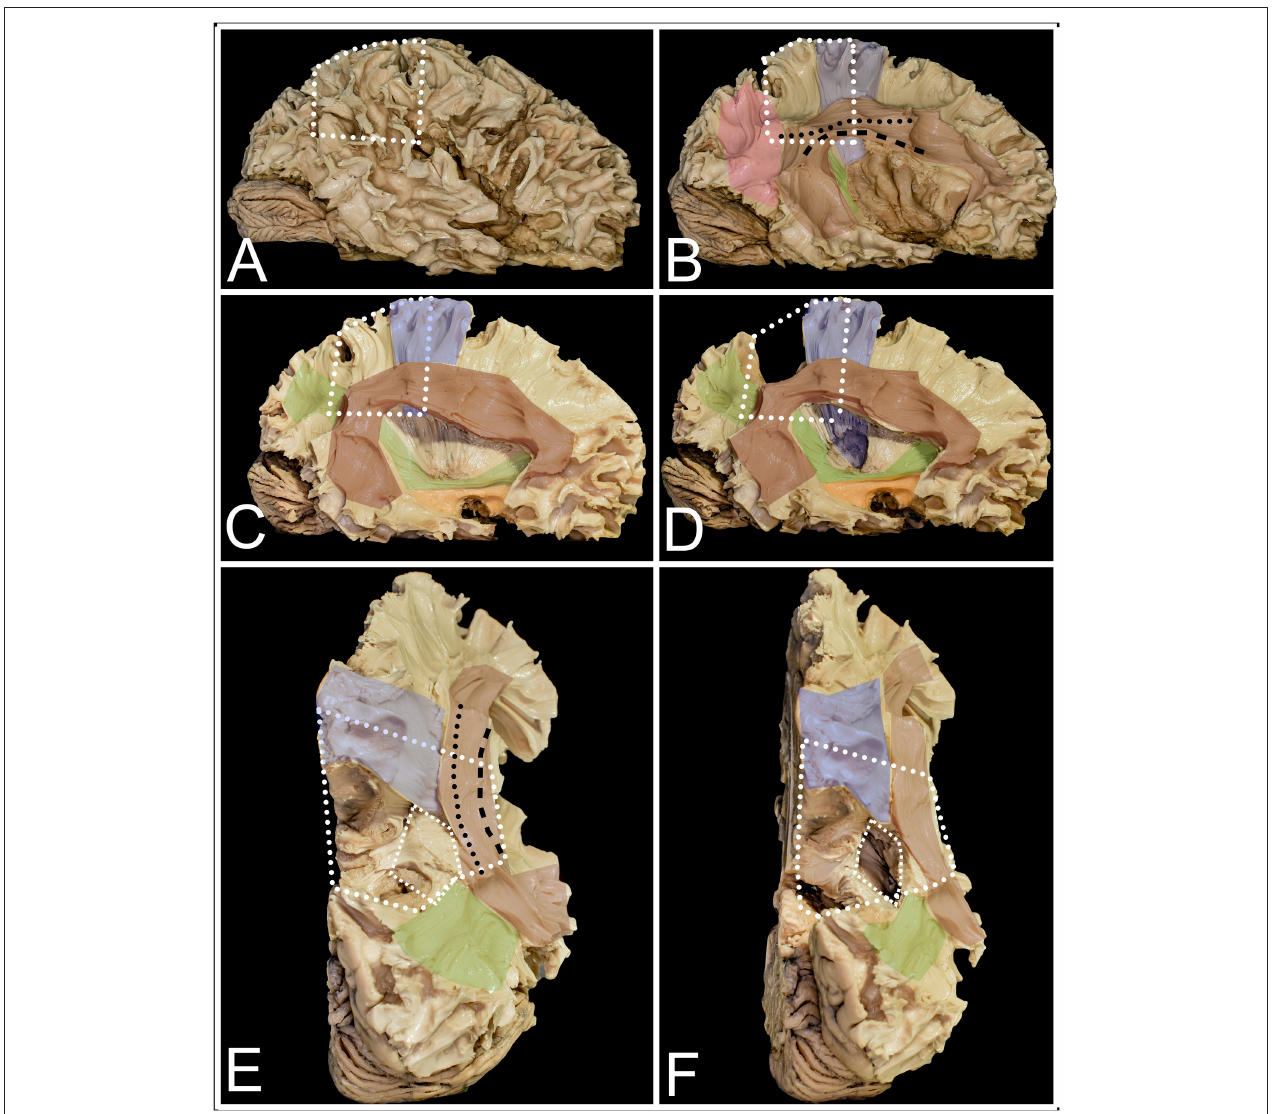
FIGURE 3 | The figure presents the anatomy of white matter tracts within and outside the parietal lobe from lateral (A–D) and superior (E,F) perspectives. White dots mark the localization of the parietal lobe within the right hemisphere. (A) After removal of the cerebral cortex, the short u-fibers connecting neighboring gyri are exposed. (B) The most superficial layer of the associated fibers is formed by the AF/SLF complex (burgundy) and by the vertical occipital fasciculus (VOF) (pink). The most superficial layer of the AF/SLF complex is formed by SLF II (black dots), which connects the angular gyrus with the middle frontal gyrus. SLF III (black rectangle) runs inferior to SLF II, without a clear demarcation between them, connecting the SMG with the inferior frontal gyrus. Medial to SLFs II and III, the AF is identified, which is difficult to separate from the SLF complex, as they have the same direction on the horizontal segment of the AF/SLF complex. Under the vertical part of the AF/SLF complex in the anteroposterior direction, the fibers of the sagittal stratum (SS) (green) are exposed. The most superficial layer of the fibers within the SS is formed by the ILF, but they run inferior to the atrium and are not related to parietal lobe surgery. A deeper layer is formed by the IFOF, which covers the whole lateral wall of the atrium. The deepest segment is formed by optic radiation (OR), which at the bottom is fused with the anterior commissure (AC). Deeper to the OR and directed perpendicular to it, the fibers of the tapetum of the lateral ventricle were identified. Mesial to the AF/SLF complex at the level of the paracentral lobule, corticospinal tract (blue) fibers are identified. (C) The mean compartment of the SS is formed by the IFOF, which is identified when the cortex of the insula is removed. Ventral to the IFOF, the uncinate fasciculus (UF) (orange), which connects the frontal and temporal lobes, is identified. (D) The precuneus was resected to expose the fibers of the paracentral lobule that marked the anterior margin of the resection. The posterior part is formed from thalamocortical fibers, which are sensory fibers. Below the AF/SLF complex, the corticospinal tract forms the posterior limb of the internal capsule, which is covered laterally by the putamen. (E) The superior perspective after removal of the precuneus. The surface marked with a line of white squares corresponds to the position of the atrium of the lateral ventricle. (F) The atrium of the lateral ventricle was opened from the superior ventricle. Lateral to it, the horizontal segment of the AF/SLF complex is identified, and posteriorly, the superior fibers form the